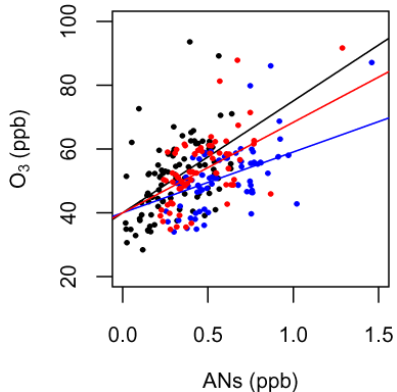
Fig. 5. Simulated fate of isoprene peroxy radicals in the IS and E (slow HO 2 + RO 2 ) cases. Results are averaged over the en- tire modeling period for the southeastern US within 2 km of the surface. ISOPO 2 refers to isoprene peroxy radicals formed from isoprene + OH reactions (Fig. 1a), and NISOPO 2 refers to those formed from isoprene + NO 3 reactions (Fig.